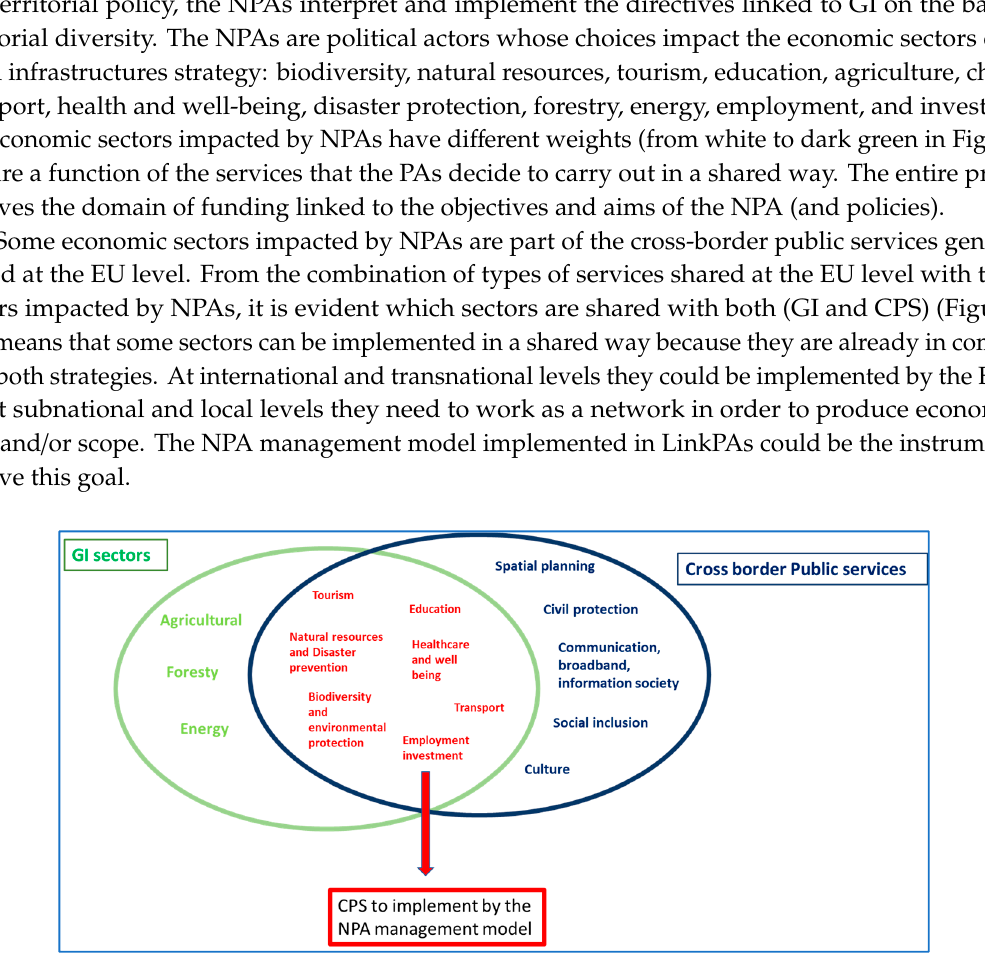
Figure 3. The network of protected areas (NPA) structure according to a unified and harmonized planning strategy framework. Source: ESPON Programme 2020, ESPON LinkPAs, Final Main Report, p. 23.